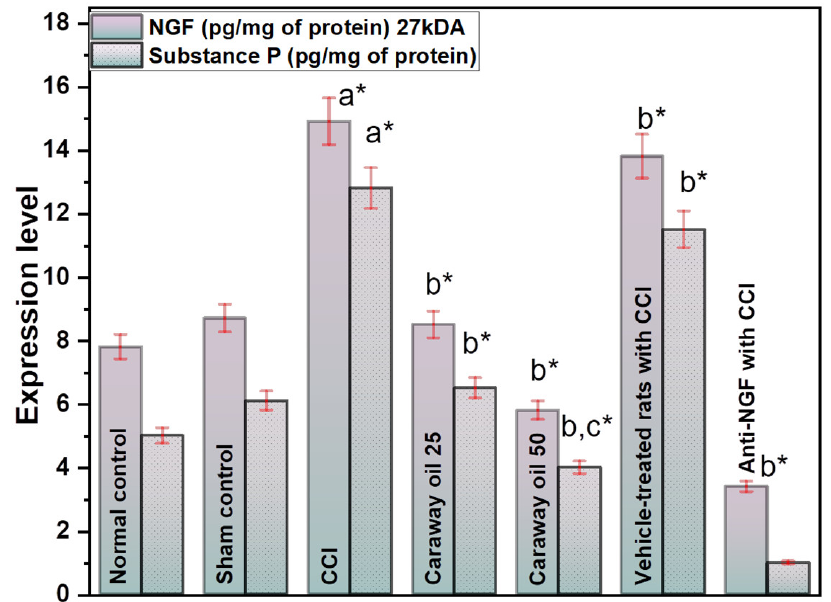
Figure 6. The effect of caraway oil on nerve growth factor and substance P in patients with CCI- induced neuropathy. It is represented as mean ± SEM; n = 6. a p ≤ 0.05 against sham control correspondent to same day. b p ≤ 0.05 against CCI comparable to same day. c p ≤ 0.05 versus caraway oil and anti-NGF in CCI compatible to same day. * represents p -value ≤ 0.05.